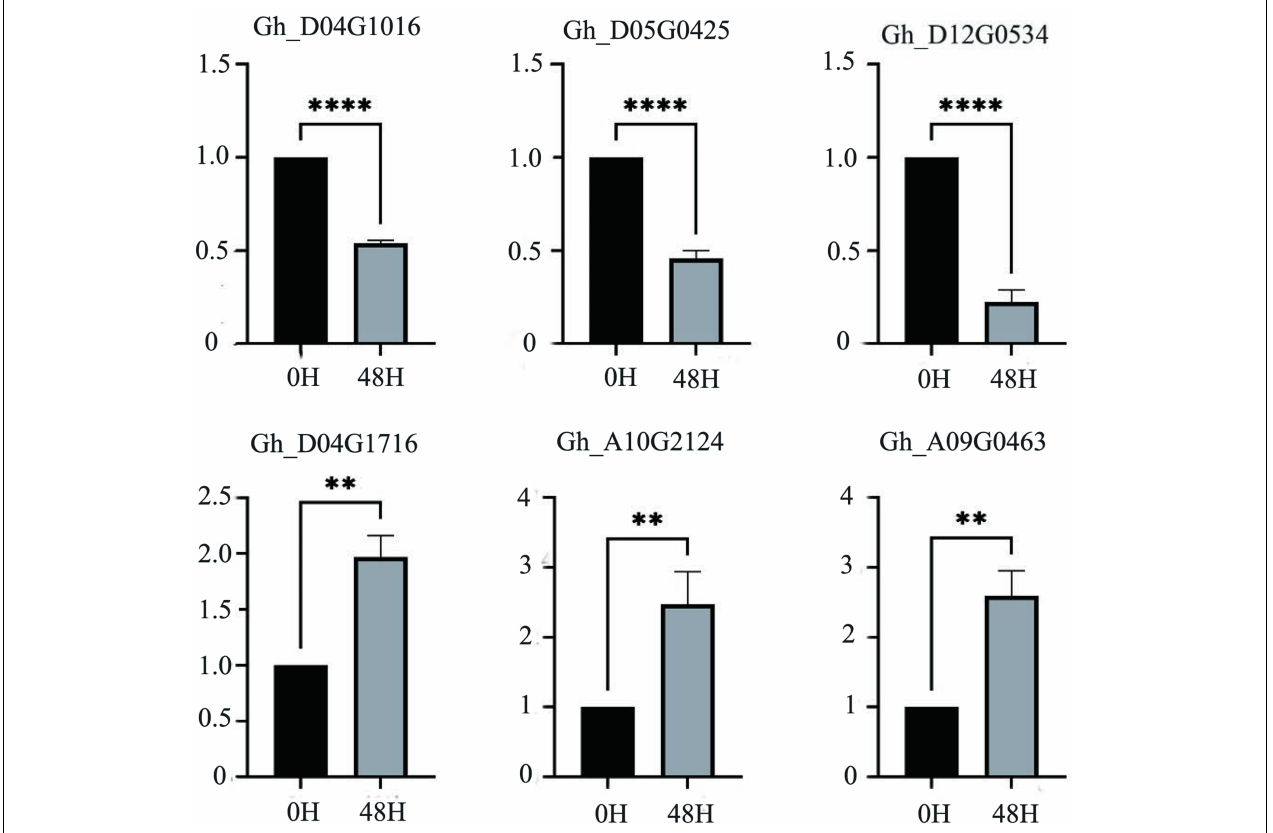
FIGURE 7 | The relative expression levels of six candidate genes in upland cotton under salt stress. A asterisk on the bars indicate significant difference at 0.05 probability level by t test. ** P ≤ 0.01, **** P ≤ 0.0001 in t